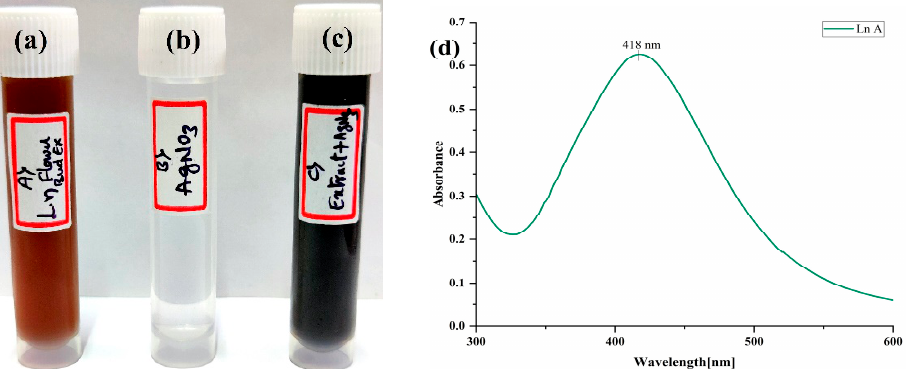
Figure 3. Change in color of the solution: ( a ) flower bud extract; ( b ) AgNO 3 solution; ( c ) flower bud extract + AgNO 3 ; ( d ) UV-Vis absorption spectrum of biosynthesized LnFb-AgNPs from L. nepetifolia flower bud extract.